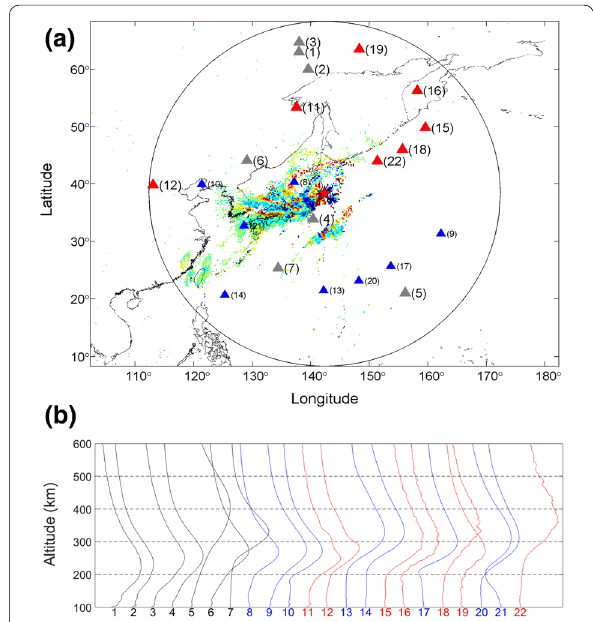
Fig. 8 a Locations of the electron density profiles observed by F3/C GOX during the Tohoku earthquake, and b the associated electron density profiles. The circle denotes the circumference with radius 3000 km from the epicenter (38.32°N, 142.37°E, star symbol). Gray and red/blue triangles are seven profiles observed within 6 h before and 22 profiles probed within 5.5 h after the earthquake, respectively. The red triangles denote seven out of the 22 profiles with prominent fluctuations after the earthquake. A snapshot of STIDs in the TEC is derived from measurements of 1000 ground‑based GPS receivers + in Japan and Taiwan at 0603 UT on March 11, 2011 (adapted from Liu et al.